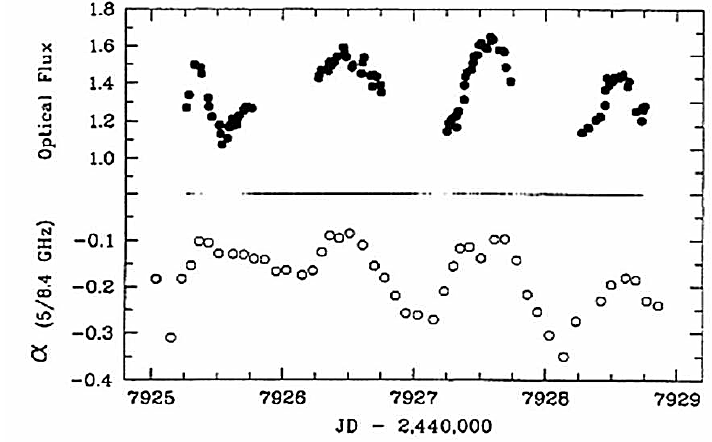
Figure 3. Observed correlations of the radio spectral index variability with the optical flux at 650 nm seen in 0716+714 [15]. Reproduced with permission from Annual Review of Astronomy and